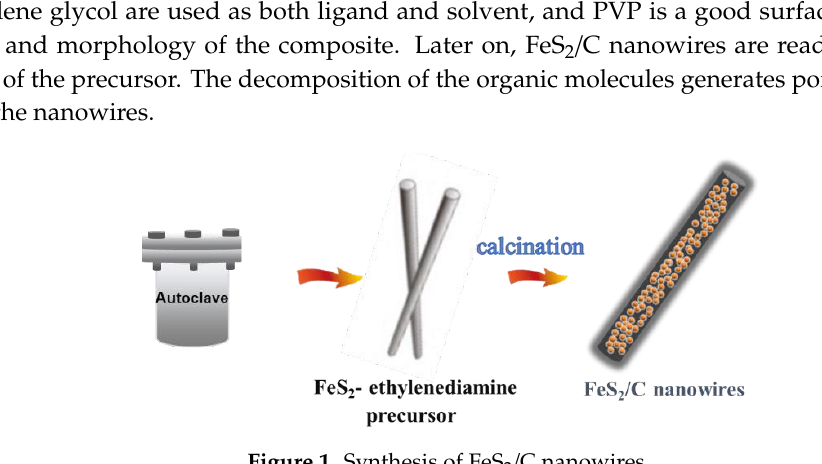
Figure 1. Synthesis of FeS 2 /C nanowires.